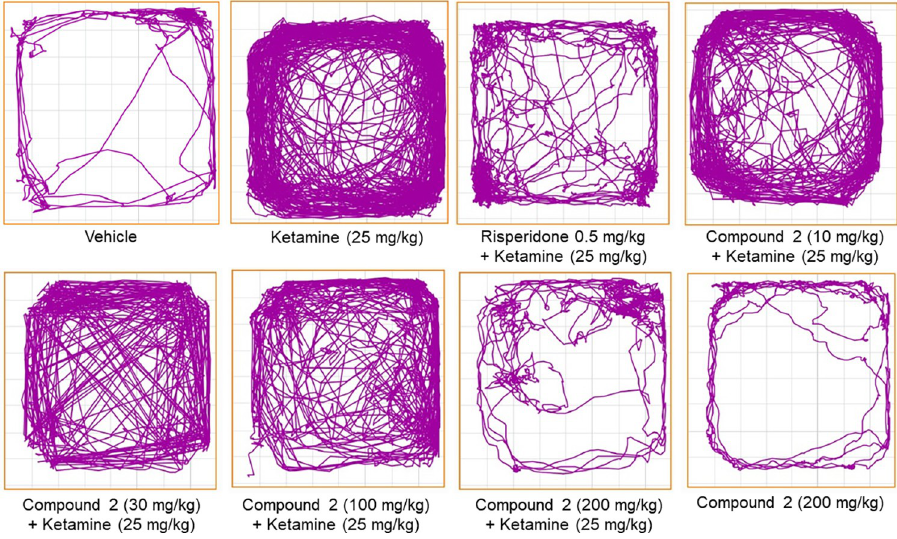
Fig 4. Representatives of track plots of locomotor activity of experimental groups of rats in open field test.